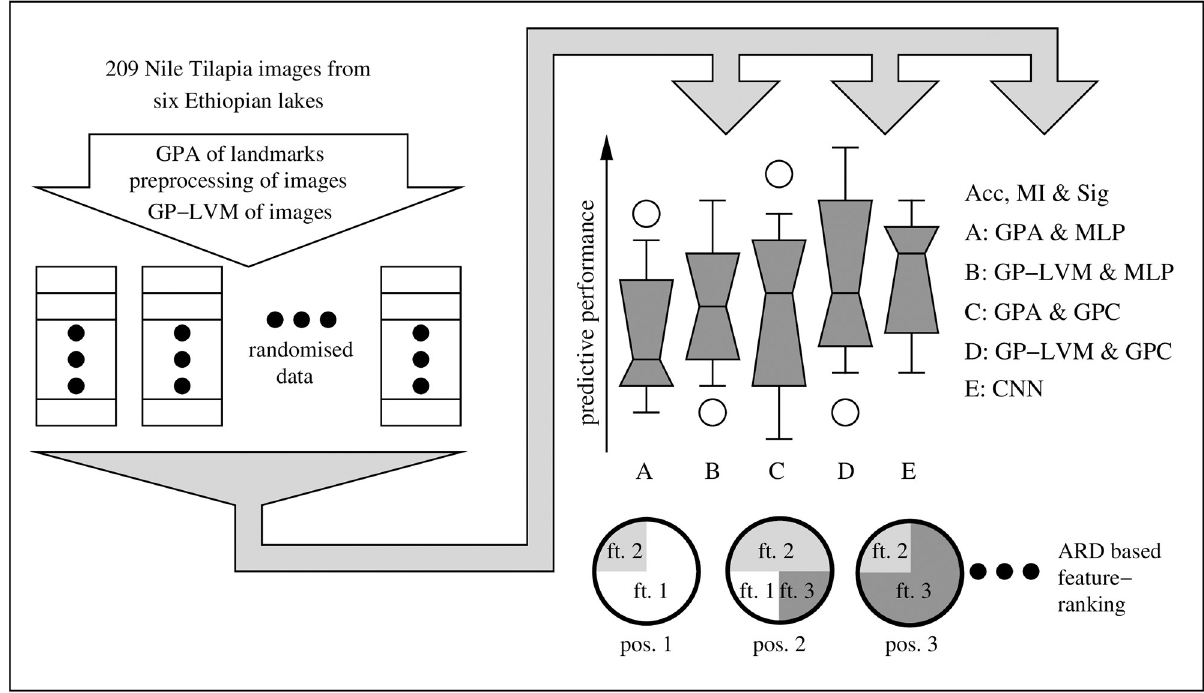
Fig 1. Data analysis of Nile tilapia images. The objective of our approach is to provide robust conclusions by randomly reshuffling the original data and repeating analysis ten times. The input features considered in our analysis are 1) established landmarks of fish morphology which underwent a generalized Procrustes analysis (GPA); 2) Gaussian process latent variable representations of fish images (GP-LVM) and 3) features extracted by deep convolutional neural networks (CNN). Nile tilapia origin is classified from GPA and selected GP-LVM features with Gaussian process classifiers (GPC) and Bayesian multi layer perceptrons which were inferred with a hybrid Monte Carlo algorithm (MLP). Combining feature extraction and classification, the CNN is directly applied to Nile tilapia images. Unbiased predictions were obtained with ten fold cross testing and assessed by generalization accuracy (Acc) and mutual information between features and labels (MI). McNemars test was used to assess the differences between the least performing classifier and all improved results for statistical significance (Sig). ARD level based feature ranks allow us to reason which visual features of Nile tilapia adapt to